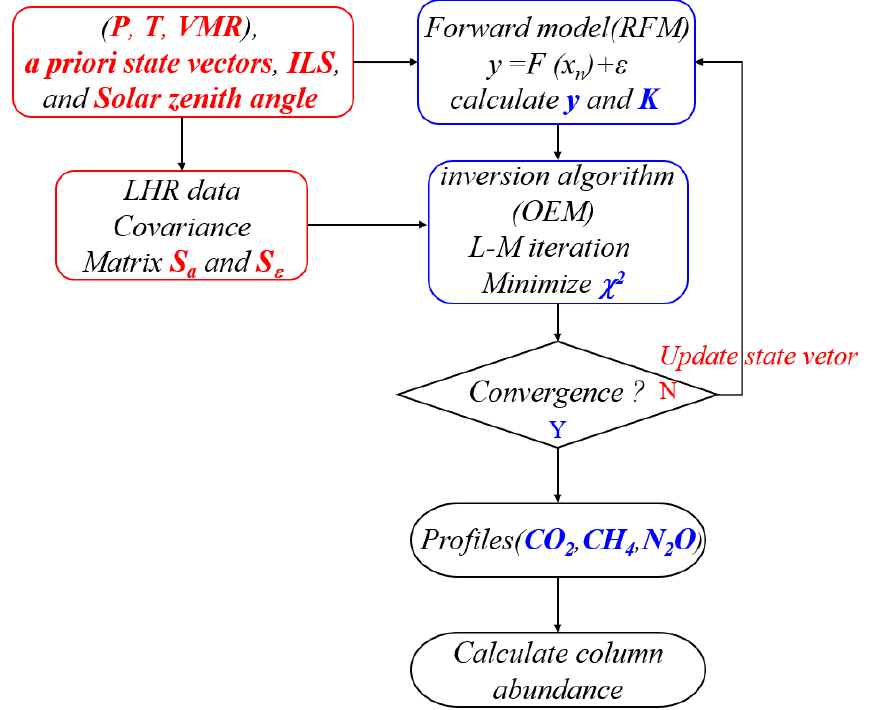
Figure 4. Flow-chart of the LHR